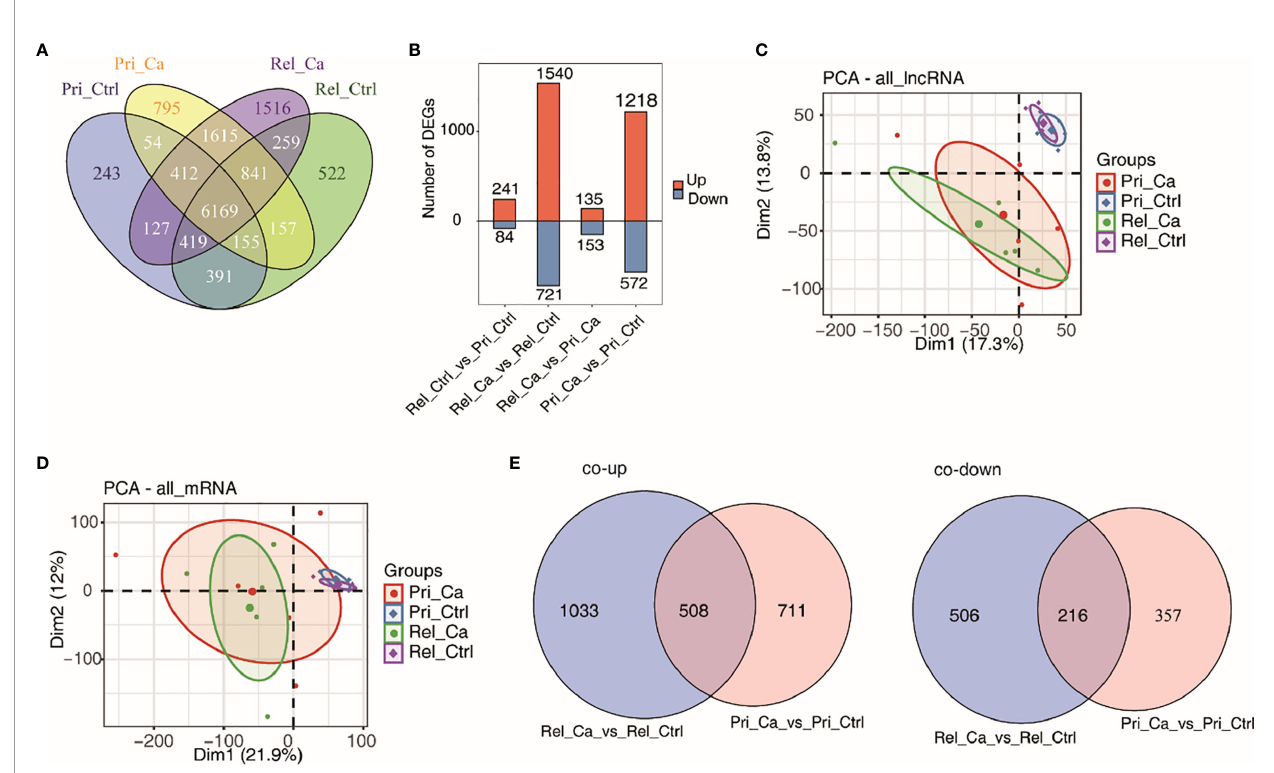
FIGURE 3 | Analysis of differential expression of lncRNA and mRNA in HCC and adjacent tissues. (A) Venn diagram of detected lncRNA genes in primary tumor, relapse tumor, benign adjacent tissue. At least two samples with RPKM>=0.2 was considered to be detected in the group. (B) The number of differentially expressed (DE) lncRNAs among different groups. Bar plot showing the number of up-regulated and down-regulated DE lncRNAs. (C, D) Principal component analysis (PCA) of primary tumor, relapse tumor, benign adjacent tissue based on normalized lncRNAs (C) and mRNAs (D) expression level. The samples were grouped by disease state and the ellipse for each group is the con fi dence ellipse. (E) Venn diagram of detected co-up-regulated (left panel) and co-down-regulated (right panel) lncRNAs in primary tumor or relapse tumor compared with benign adjacent liver